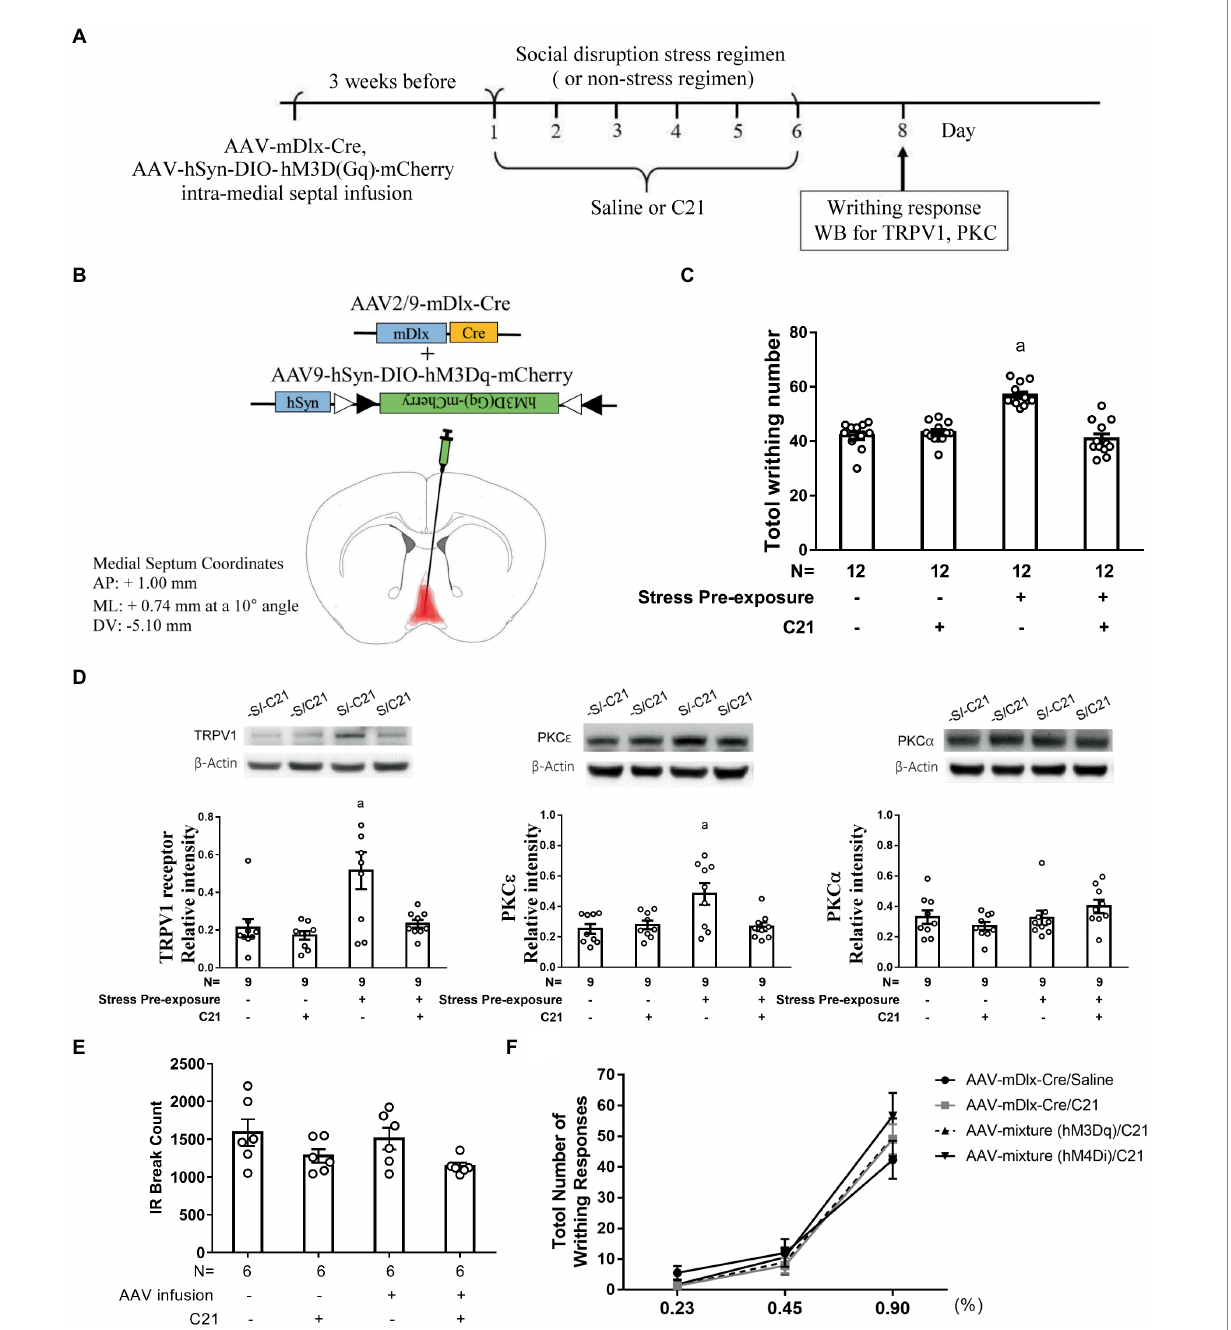
FIGURE 3 Enhancing medial septal GABAergic activity prevented stress-primed writhing escalation and accumbal TRPV1 and PKC ε over-expression. (A) Timeline for viral infection, C21 treatment, the stress regimen, writhing response test and Western assay. (B) Intra-medial septal viral mixture infusion. Viral mixture with a total volume of 0.5 μ l consists of AAV2/9 encoding mDlx-cre recombinase (2.84 × 10 12 gc/ml) and a cre-inducible AAV9 encoding hM3Dq and mCherry (2.4 × 10 13 gc/ml). Overlayed red shaded area indicates all confirmed AAV-mCherry labeling results. (C) Total acetic acid-induced writhing responses. a Significantly greater than the remaining three groups. (D) Accumbal TRPV1, PKC ε and PKC α level. a Significantly greater than the remaining three groups. (E) No effects of C21 administration or intra-medial septal viral infusion on animals’ locomotor activity. (F) Effects of C21 administration or intra-medial septal viral infusion and C21 in combination on acid concentration-dependent curve. [AAV-mixture (hM3Dq): AAV-mDlx-Cre and AAV- hSyn-DIO-hM3Dq-mCherry in combination; AAV-mixture (hM4Di): AAV-mDlx-Cre and AAV-hSyn-DIO-hM4Di-mCherry in combination]. Graphs show mean ±